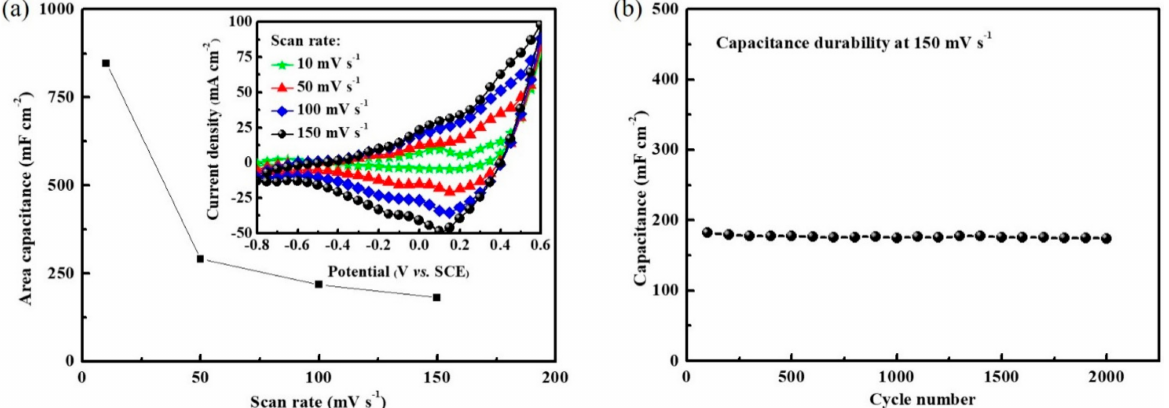
Figure 6. ( a ) Variation of areal capacitance for scan rate by using the Co 3 O 4 /SiC NTA electrode, which was obtained from the cyclic voltammetry curves, as shown in the inset. ( b ) The capacitance durability of Co 3 O 4 /SiC NTA electrode measured at 150 mV s − 1